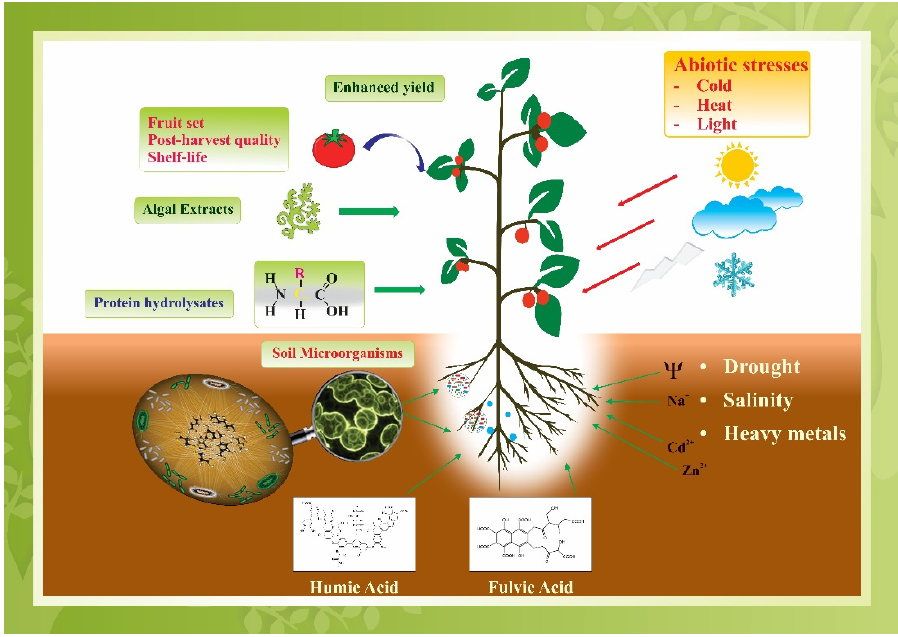
Figure 2. Biostimulants induced physiological effects and tolerance to abiotic stresses [101].